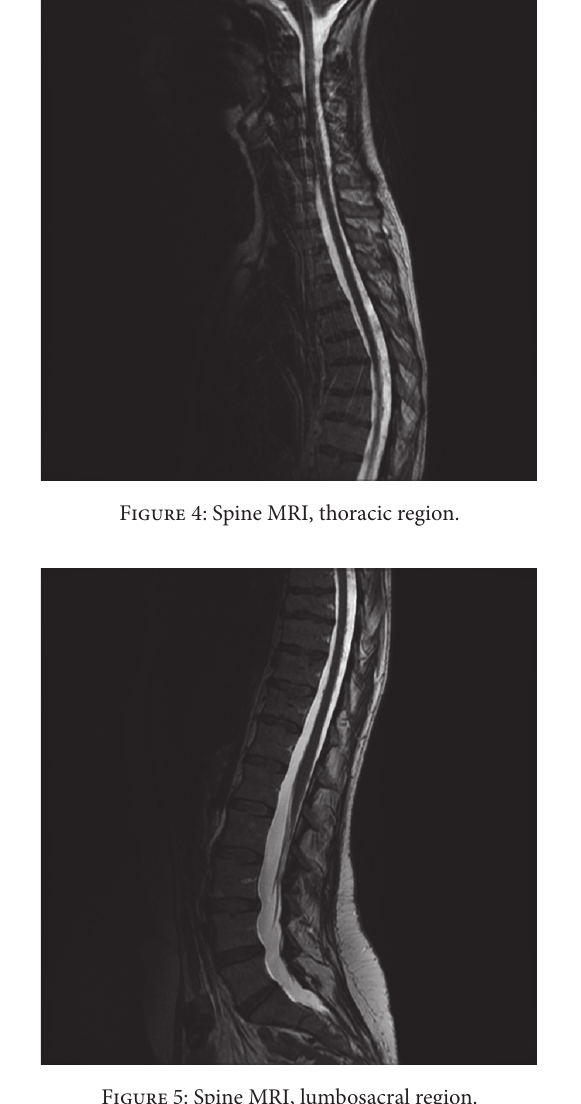
Figure 5: Spine MRI, lumbosacral region.